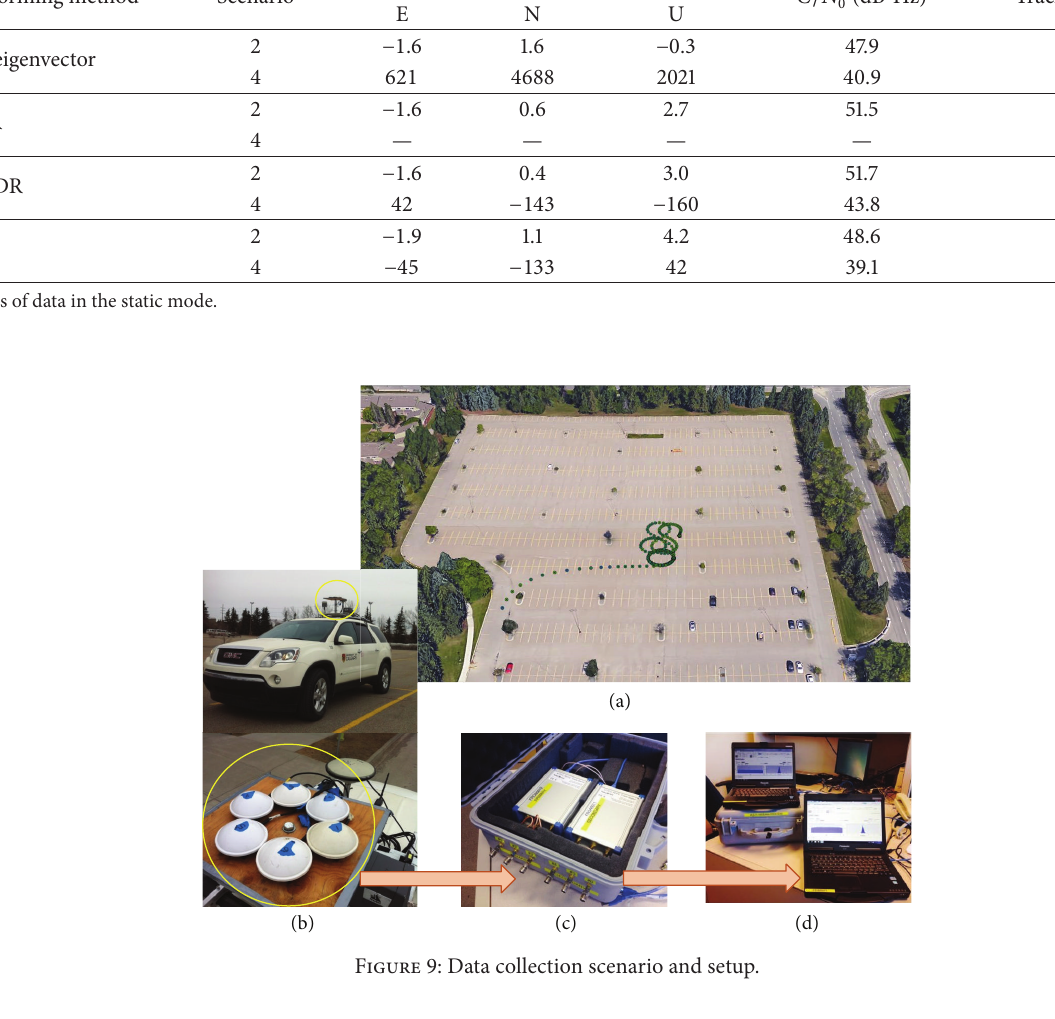
Table 14: GPS position domain results for different methods and interference scenarios (for live GPS signals) ∗ . Beamforming method